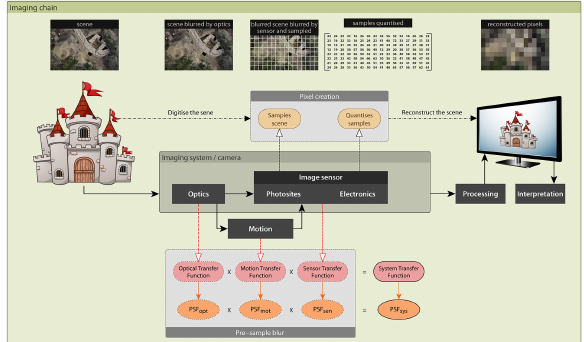
Figure 2. The complete imaging chain (including sampling and quantisation) and the individual blurring